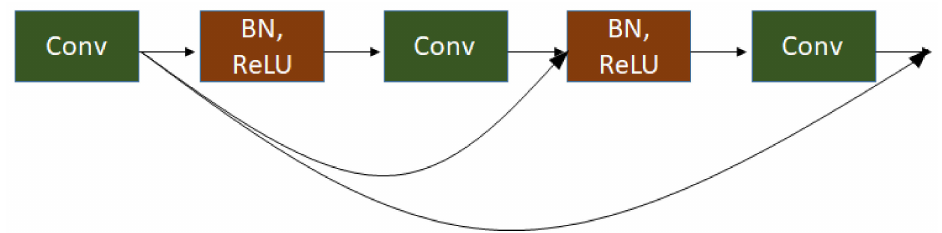
Figure 3. Interleaved residual block with 3 convolutional